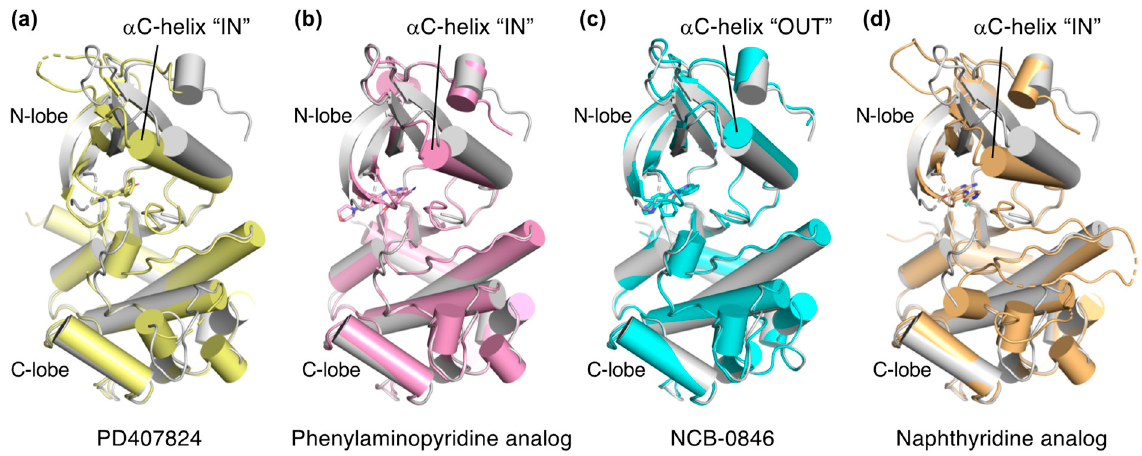
Figure 3. Comparison of the structures of inhibitor-bound TNIK (shown in different colors) and apo-form TNIK (gray) (PDB ID: 5CWZ) [12]. Bound inhibitors are shown as stick models. ( a ) PD407824 (PDB ID: 2X7F). ( b ) Phenylaminopyridine analog (PDB ID: 5AX9). ( c ) NCB-0846 (PDB ID: 5D7A). ( d ) Naphthyridine analog (PDB ID: 6RA5).